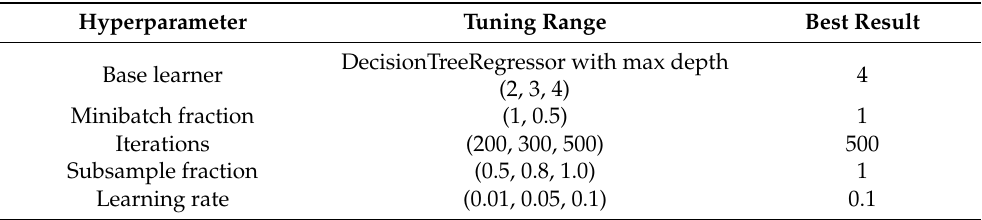
Table 4. Hyperparameter tuning information of the NGBoost